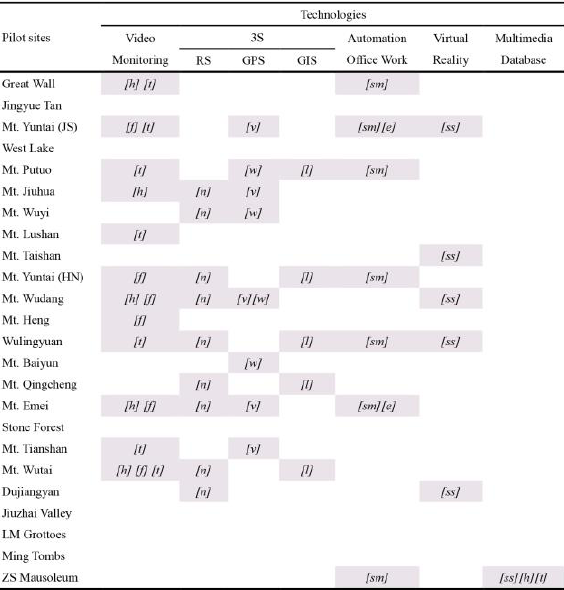
Figure 3 Technologies used in the DSA projects and their